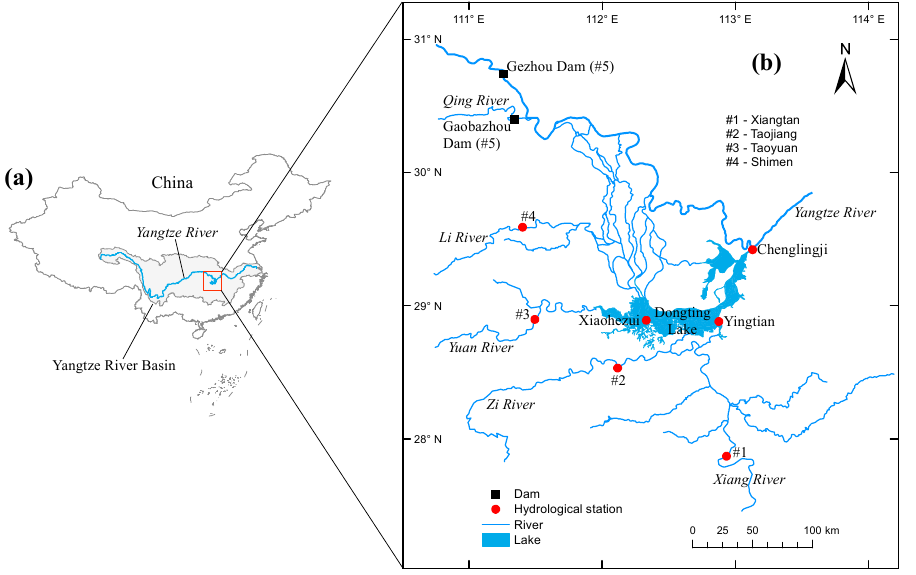
Figure 1. Map of the study area, showing ( a ) its location and ( b ) the Yangtze River–Dongting Lake water system. #1—Xiangtan, #2—Taojiang, #3—Taoyuan, #4—Shimen, #5—Gezhou